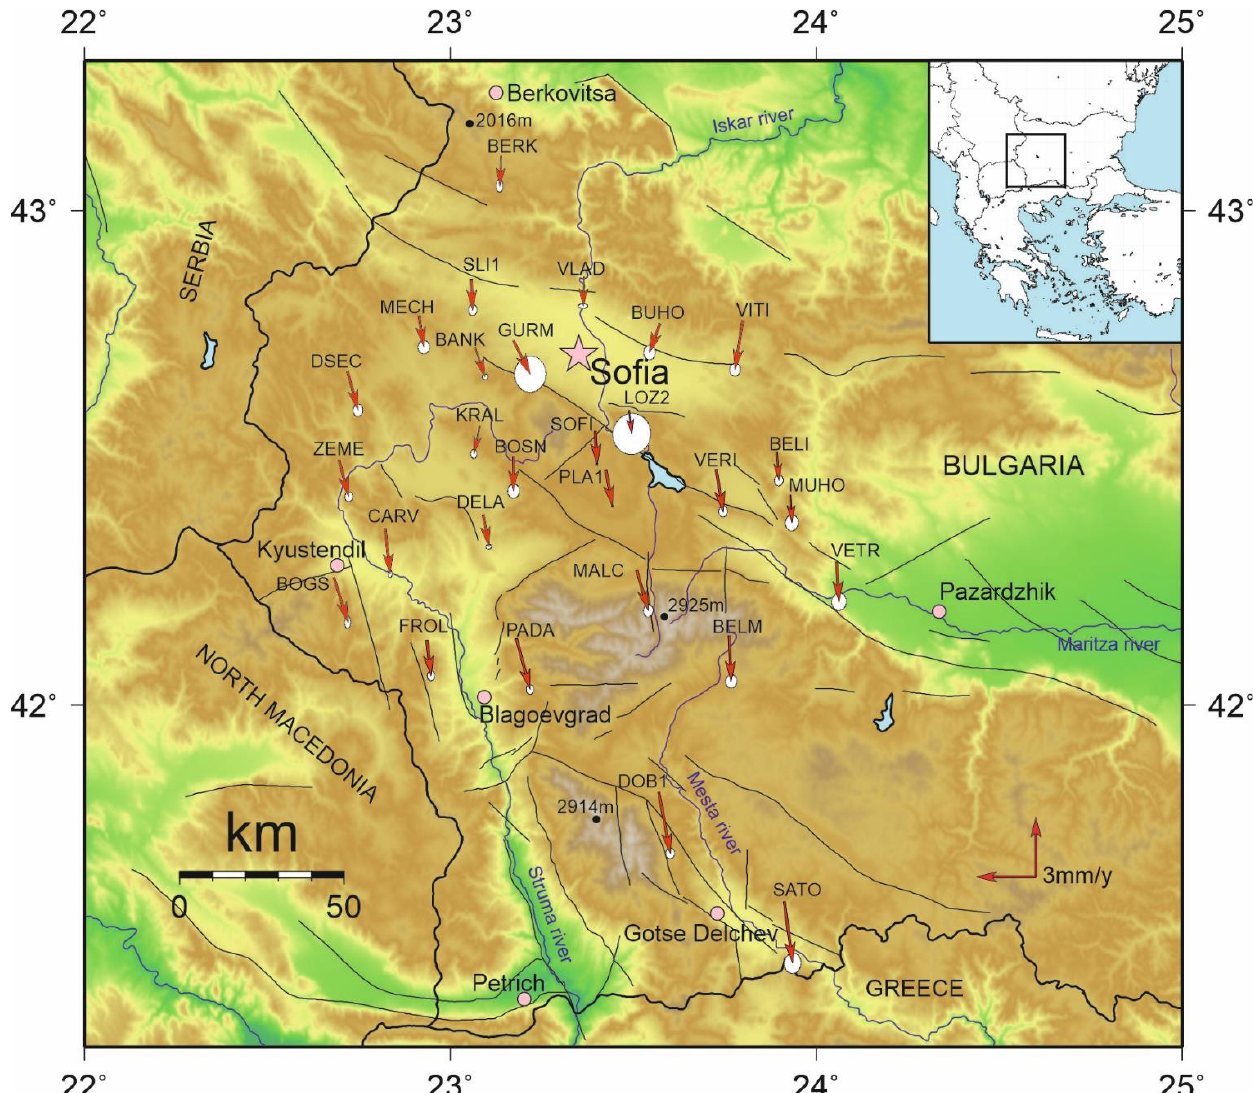
Figure 1. Horizontal GPS velocity with respect to Eurasian plate with 95% confidence. Slim lines show suggested active faults in the area. The topography is shown from green to brown — lower to higher elevation, respectively. The elevation of the highest peaks in the area is given in meters.